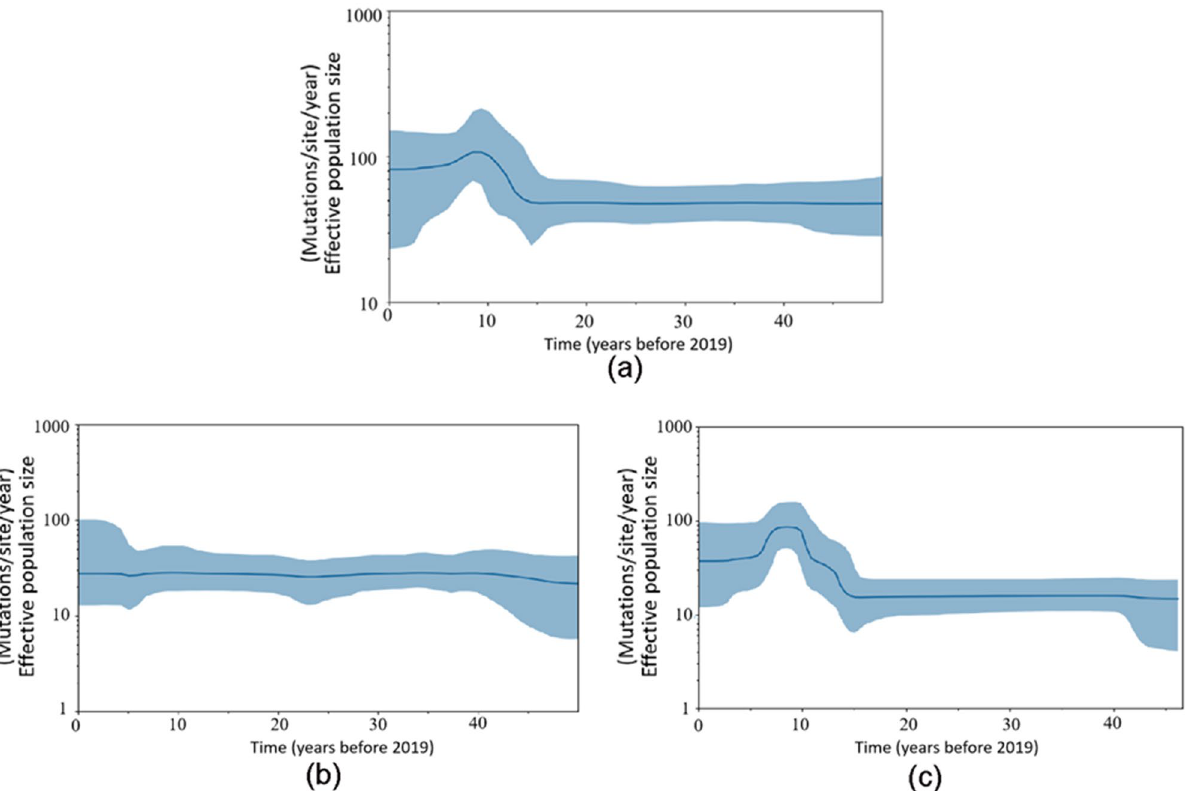
Figure 3. Population dynamics of the G gene for the RSV population using Bayesian skyline plot analyses. ( a ) both the RSV-A and RSV-B strains; ( b ) RSV-A; ( c ) RSV-B. The thick solid lines indicate mean effective population sizes; blue shadings stand for 95%